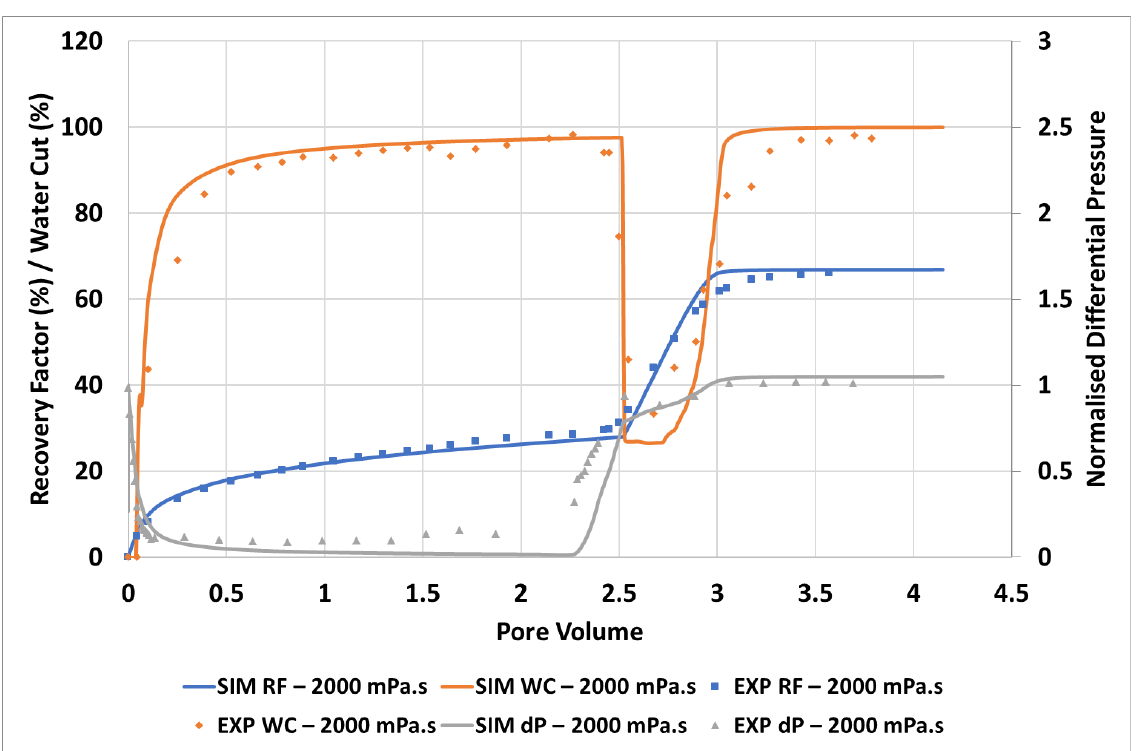
Figure 4. Simulation match of the unstable displacement of 2000 mPa.s oil.